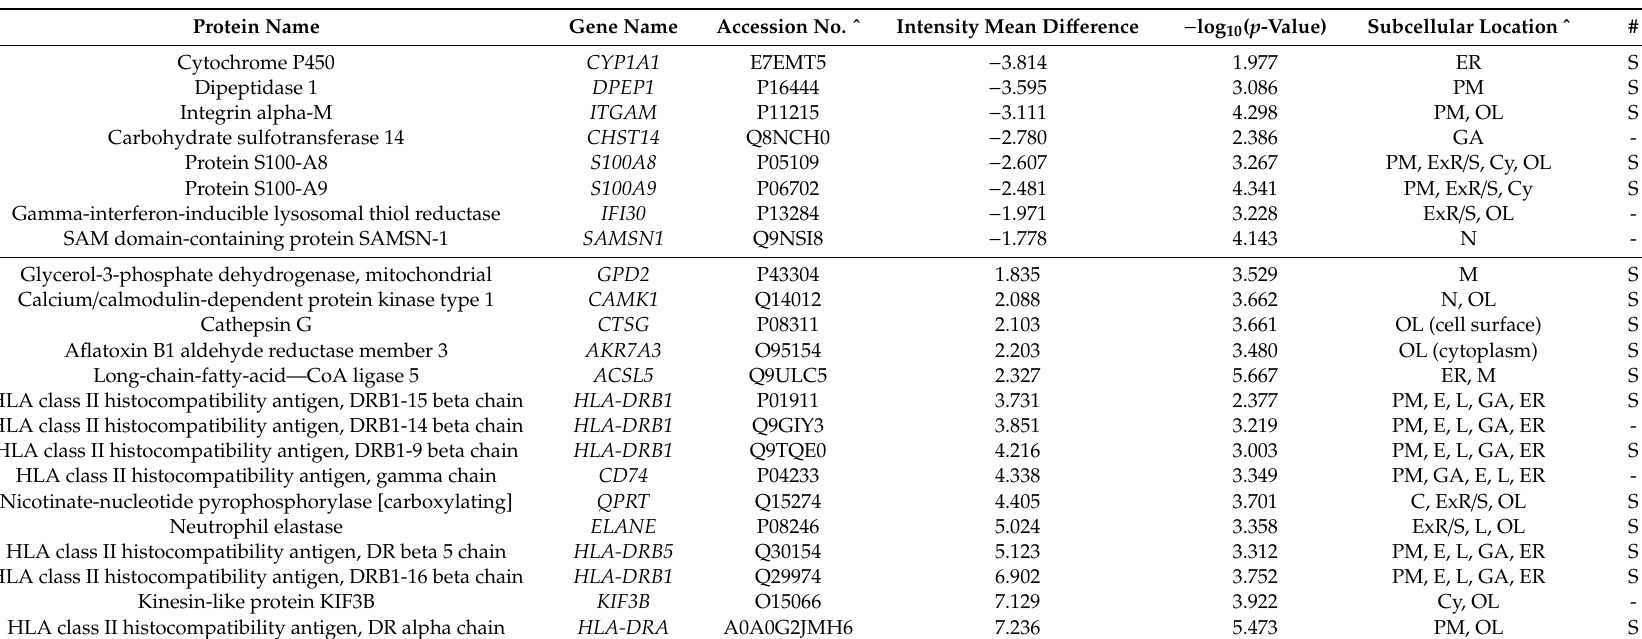
Table 3. LC-MS / MS identification results of di ff erentially expressed protein spots in U937 control cells upon the two experimental schemes (Ctrl 24 h + 24 versus Ctrl 1 h +